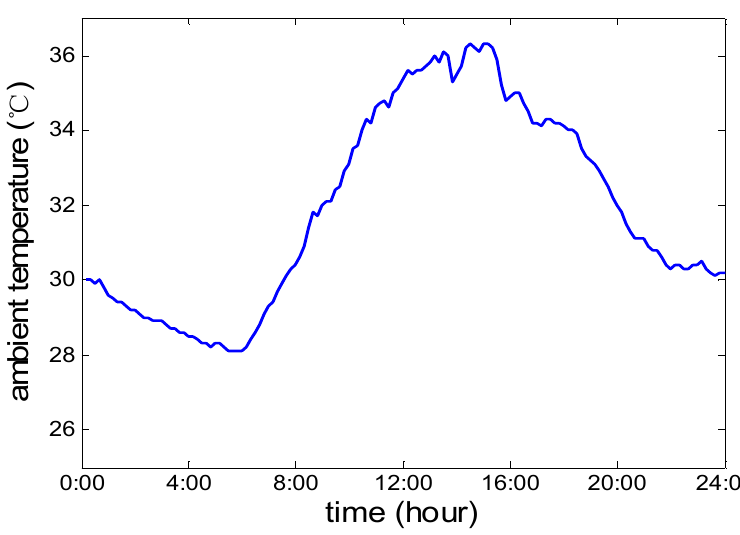
Figure 18. Realistic variable ambient temperature.